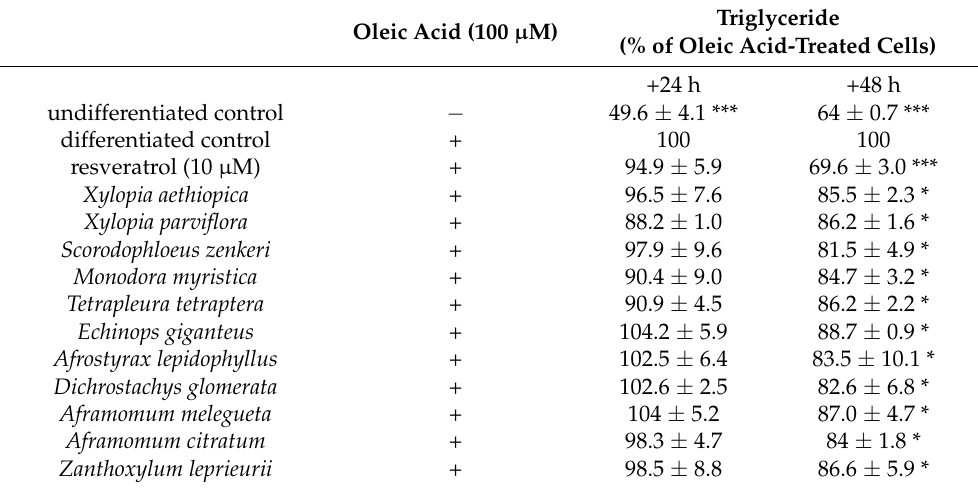
Table 1. Triglyceride accumulation in differentiated SW 872 adipocytes: effect of spice